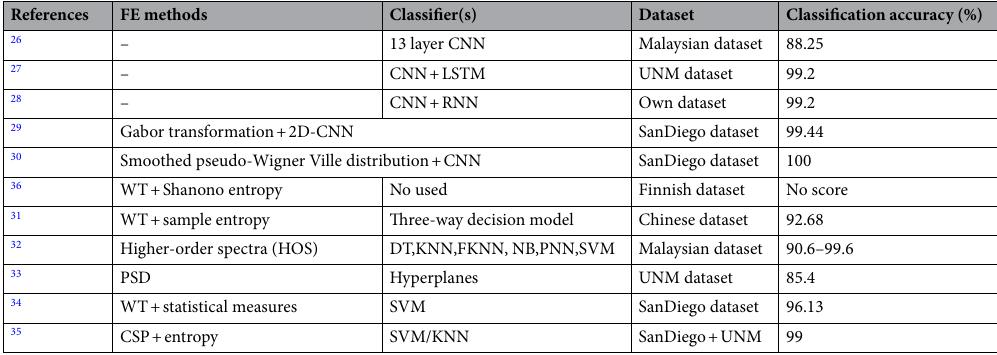
Table 1. Summaries of methods of previous studies and their corresponding